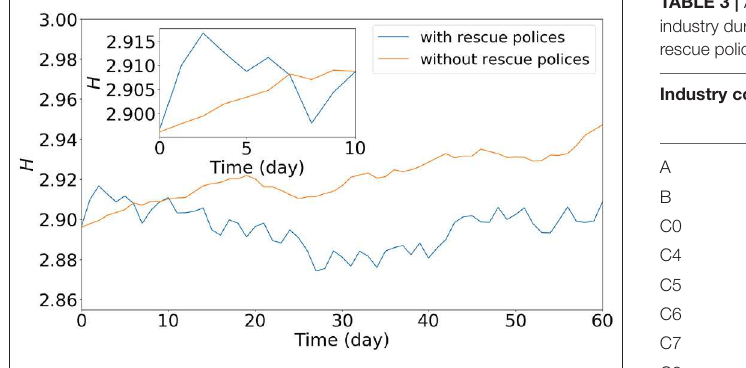
FIGURE 2 | Entropy evolution of the stock network during sub-periods with and without rescue policies after crashes in the Shanghai stock market.